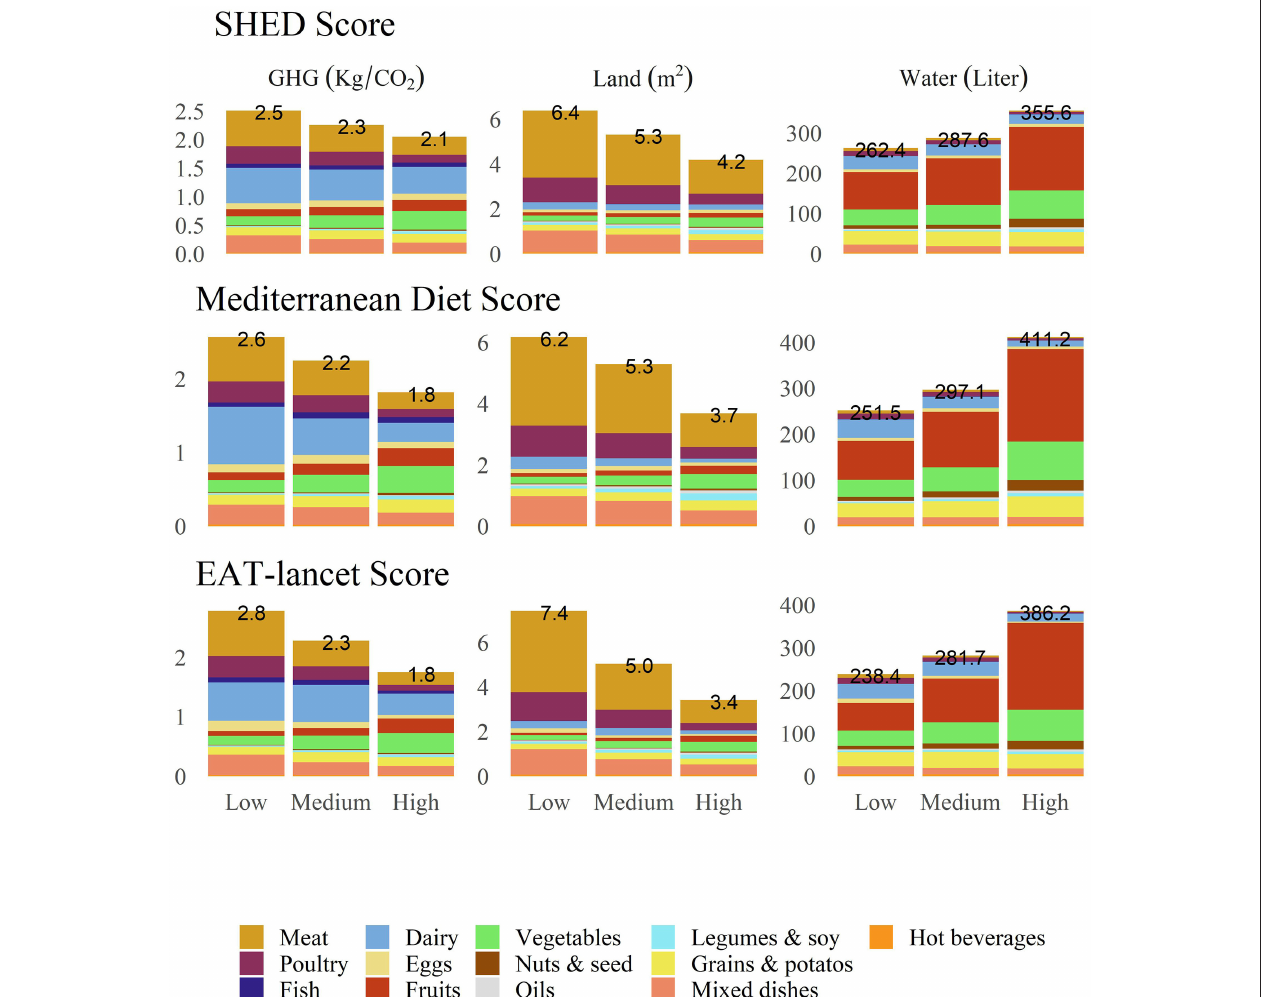
FIGURE 3 | Food groups’ contribution to environmental footprints for different dietary patterns. *All P < 0.0001 (Kruskal-Wallis